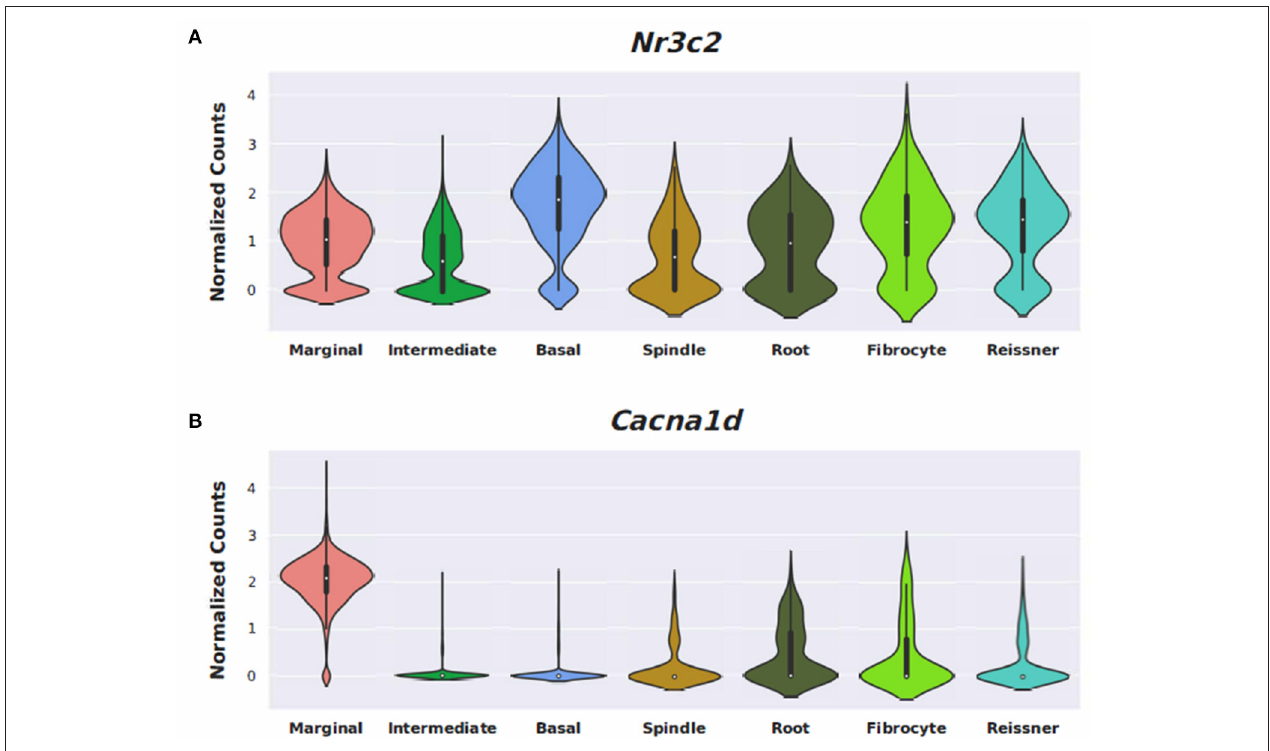
FIGURE 6 | Expression of Nimodipine drug targets, Nr3c2 , and Cacna1d , in the adult mouse stria vascularis (SV). Expression of Nr3c2 (A) and Cacna1d (B) in an adult mouse stria vascularis (SV) single-nucleus RNA-Seq dataset ( 16). Expression is displayed as normalized counts along the vertical axis and SV cell types (marginal, intermediate, basal, and spindle) along with root cells, fibrocytes, and Reissner’s membrane cells are displayed along the horizontal